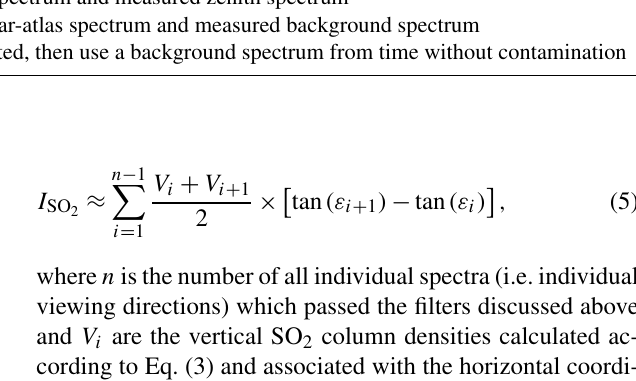
Table 4. Four different approaches for the retrieval of the background SO 2 slant column density. Approach 1